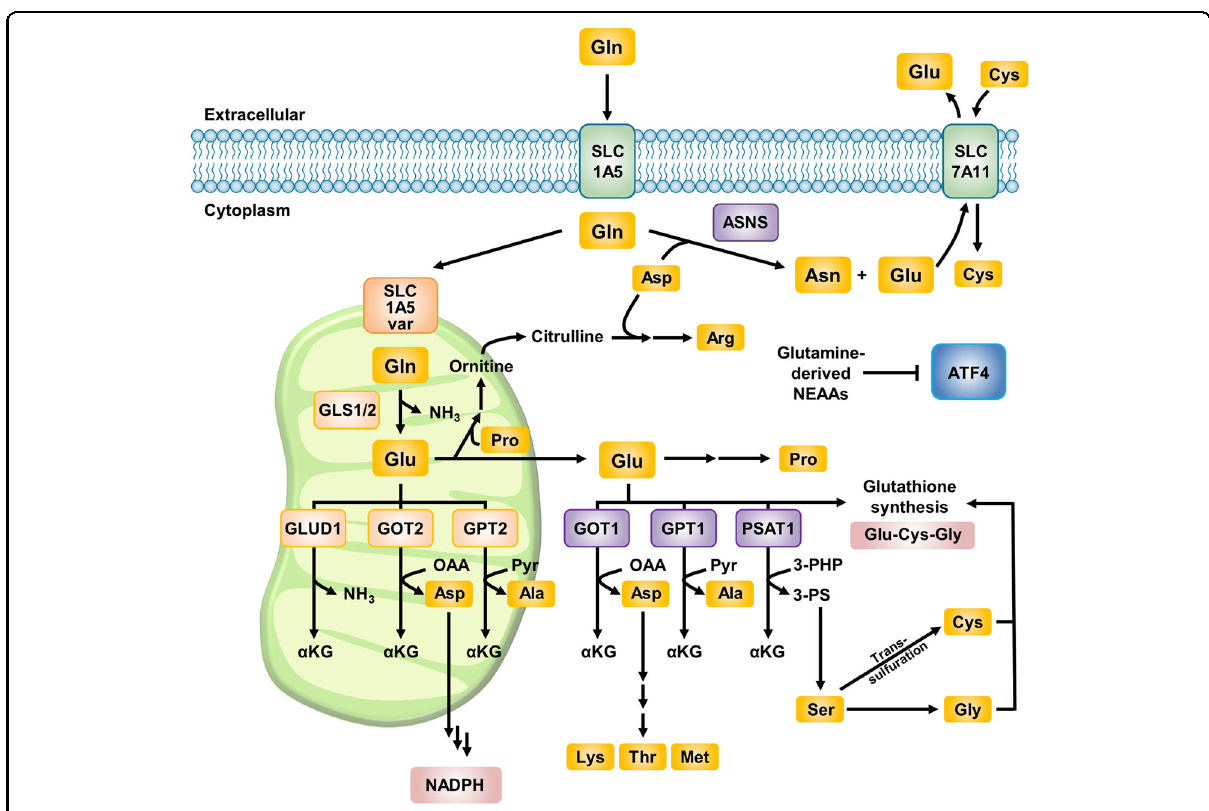
Fig. 3 NEAAs synthesized from glutamine. Intracellular glutamine is converted into diverse NEAAs and supports protein translation and amino acid signaling. Glutamine-derived glutamate plays a central role as a substrate for several aminotransferases producing aspartate, alanine, proline, arginine, serine, cysteine, and glycine. ASNS directly utilizes cytosolic glutamine to synthesize Asn, which plays a distinct role in glutamine-related metabolism. Collectively, glutamine-derived NEAAs suppress ATF4, which is a master transcriptional regulator stimulated under stress conditions. NEAAs nonessential amino acids, GLS glutaminase, GLUD glutamate dehydrogenase, GOT glutamic-oxaloacetic transaminase, GPT glutamic-pyruvate transaminase, PSAT phosphoserine aminotransferase, ATF activating transcription factor, ASNS asparagine synthetase, Gln glutamine, Glu glutamate, Pro proline, Asp aspartate, Ala alanine, Ser serine, Gly glycine, Cys cystine, Asn asparagine, Lys lysine, Thr threonine, Met methionine, aKG α - ketoglutarate, OAA oxaloacetate, Pyr pyruvate, PHP phosphohydroxypyruvate, PS